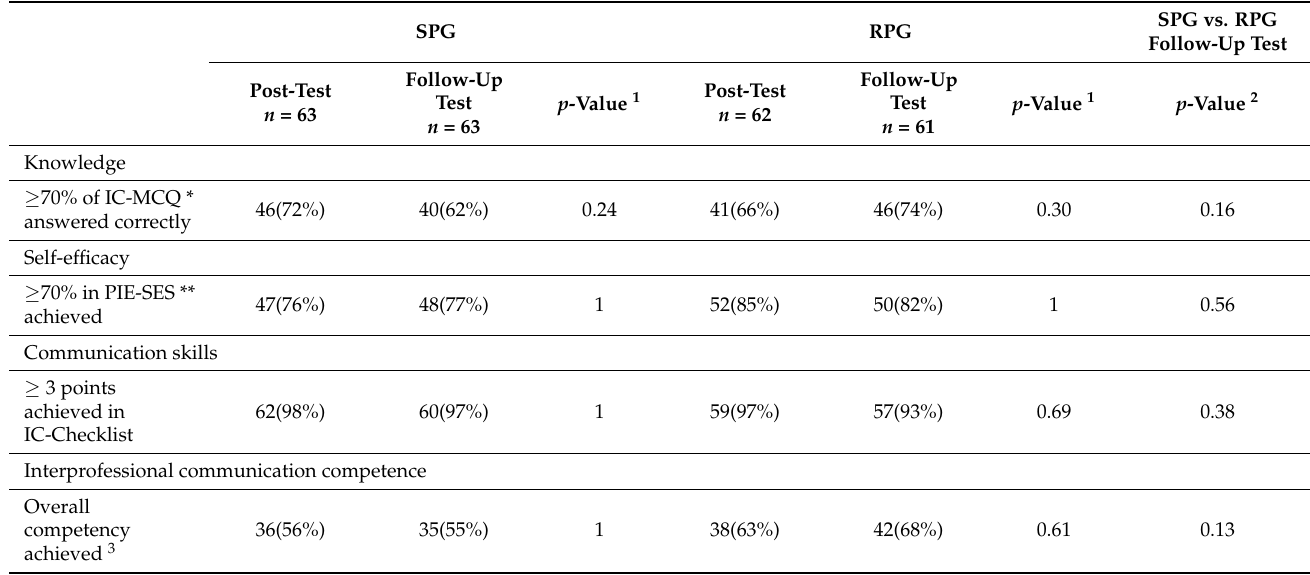
Table 4. Counts (proportions) of dichotomous interprofessional communication competency parame- ters per group for post-test and follow-up test.